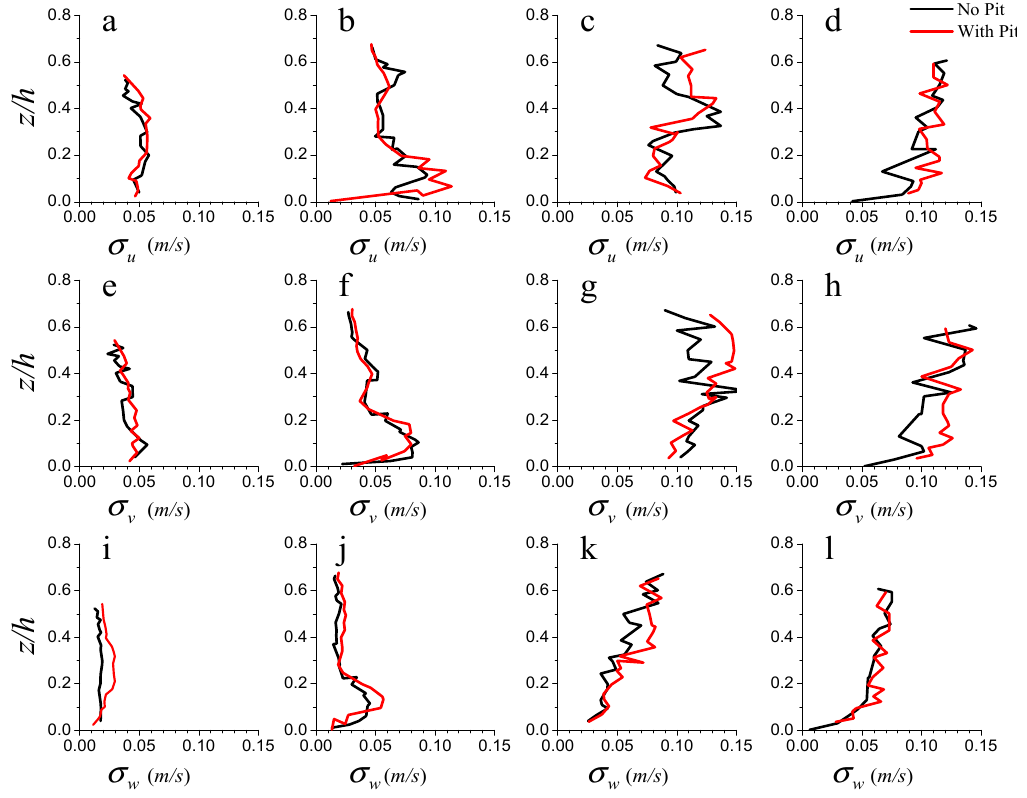
Figure 6. Streamwise turbulence intensity profiles at ( a ) Location 1, ( b ) Location 2, ( c ) Location 3, and ( d ) Location 4. Transverse turbulence intensity profiles at ( e ) Location 1, ( f ) Location 2, ( g ) Location 3, and ( h ) Location 4. Vertical turbulence intensity profiles at ( i ) Location 1, ( j ) Location 2, ( k ) Location 3, and ( l ) Location 4.